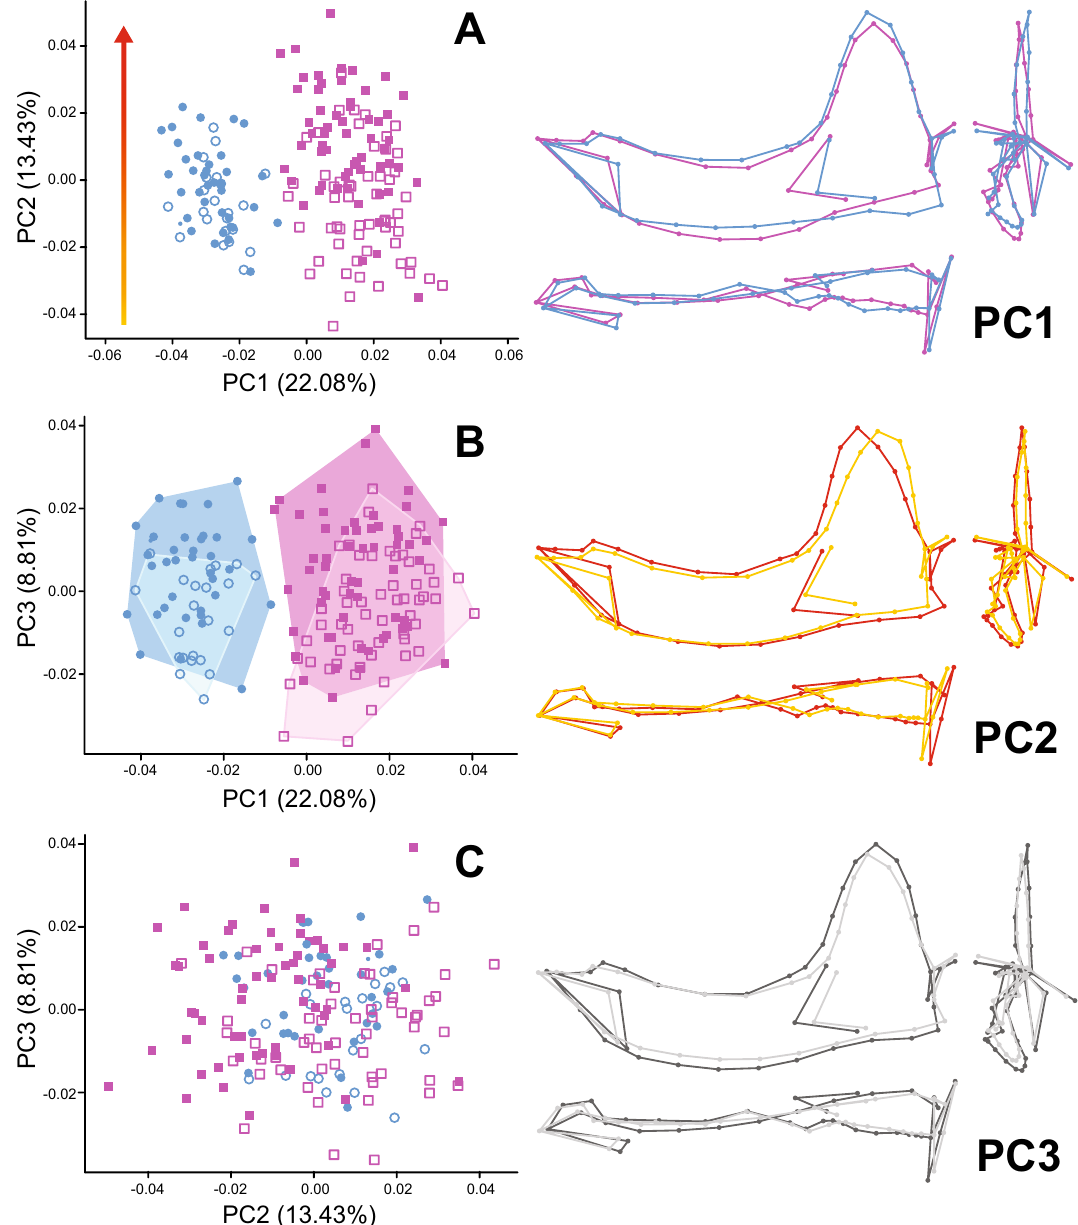
Figure 2. Principal component analyses of mandible shape variation in minks. ( A ) PC1 vs PC2, ( B ) PC1 vs PC3, ( C ) PC2 vs PC3. The percentage of total variance explained by each principal component is given in parentheses. Key: blue circles, European mink (Mlu); pink squares, American mink (Nvi); solid symbols, males; open symbols, females. Minimum convex polygons for males (darker shades) and females (lighter shades) of each species are drawn on panel ( B ). The wireframes on the right illustrate the shape variation along each PC from the lowest (PC1: blue/Mlu; PC2: yellow/small; PC3: light grey/female) to the highest score (PC1: pink/Nvi; PC2: red/large; PC3: dark